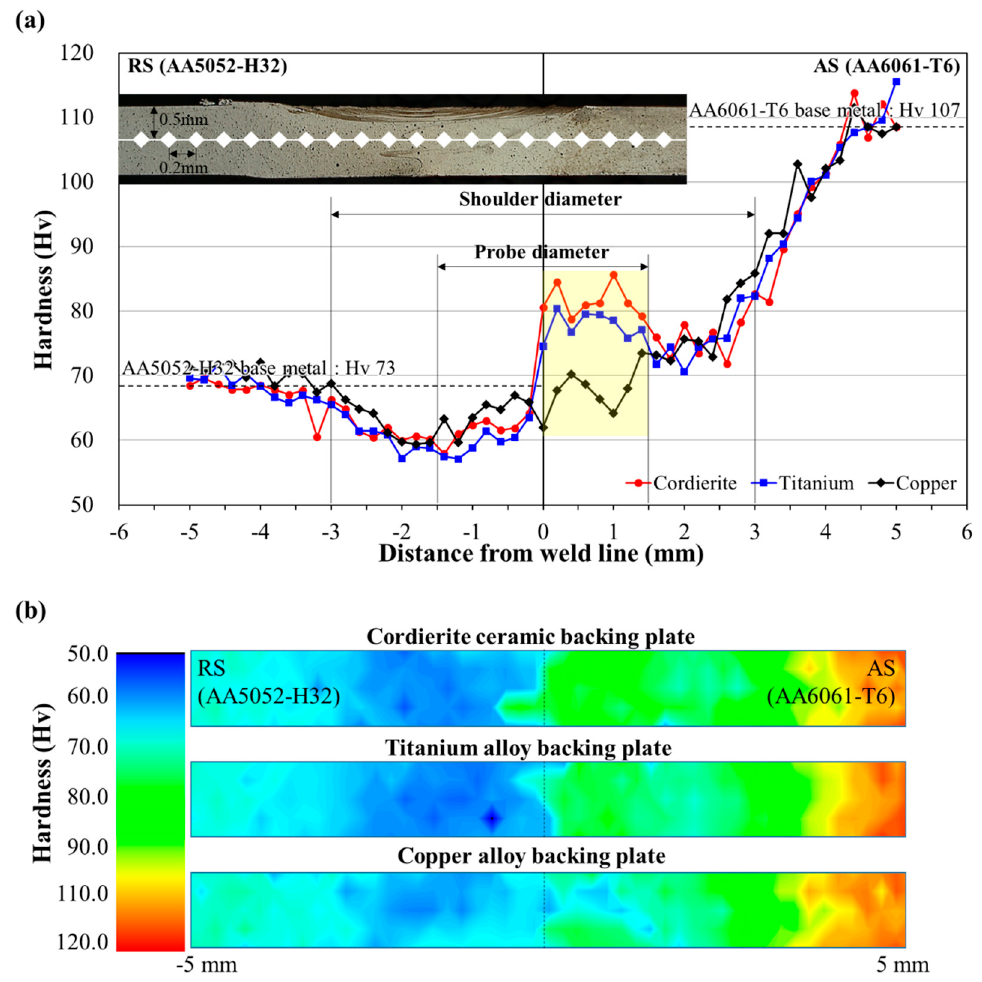
Figure 6. ( a ) Hardness profile measured at the center of the cross section and ( b ) microhardness maps of the joints obtained using different BP materials.